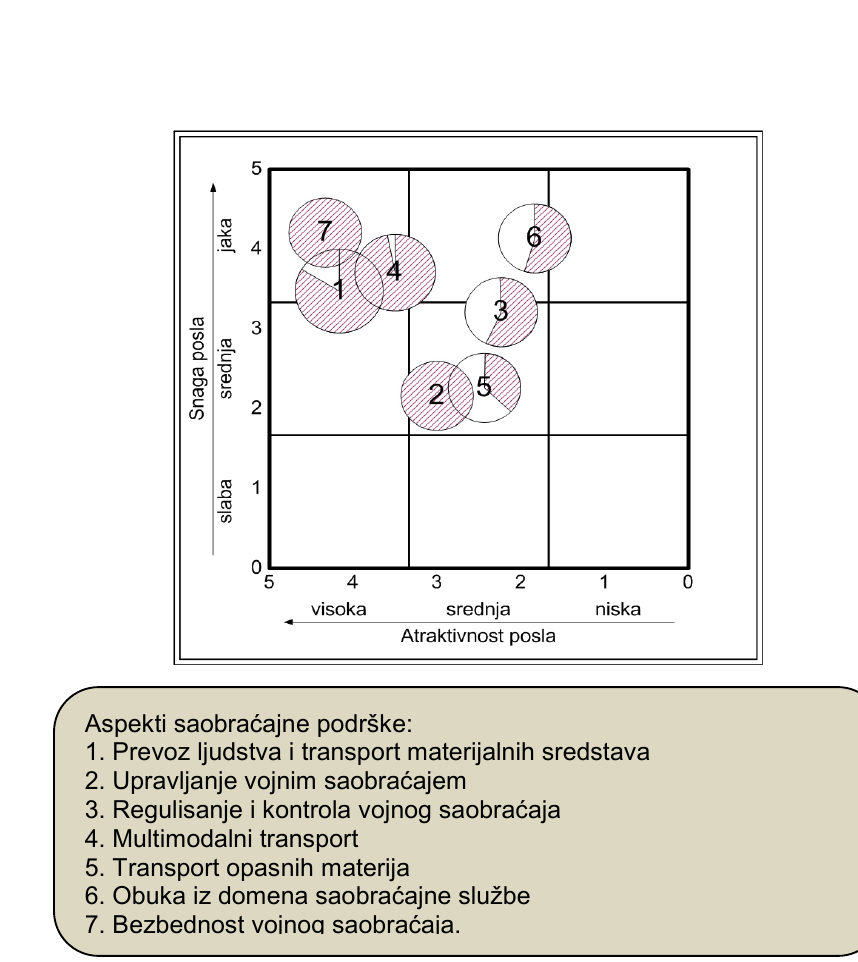
Figure 3 – Job atractivity / job strenght matrix for the aspects of movement and transpor- tation service (Further positions of the movement and transportation service jobs in the Army of